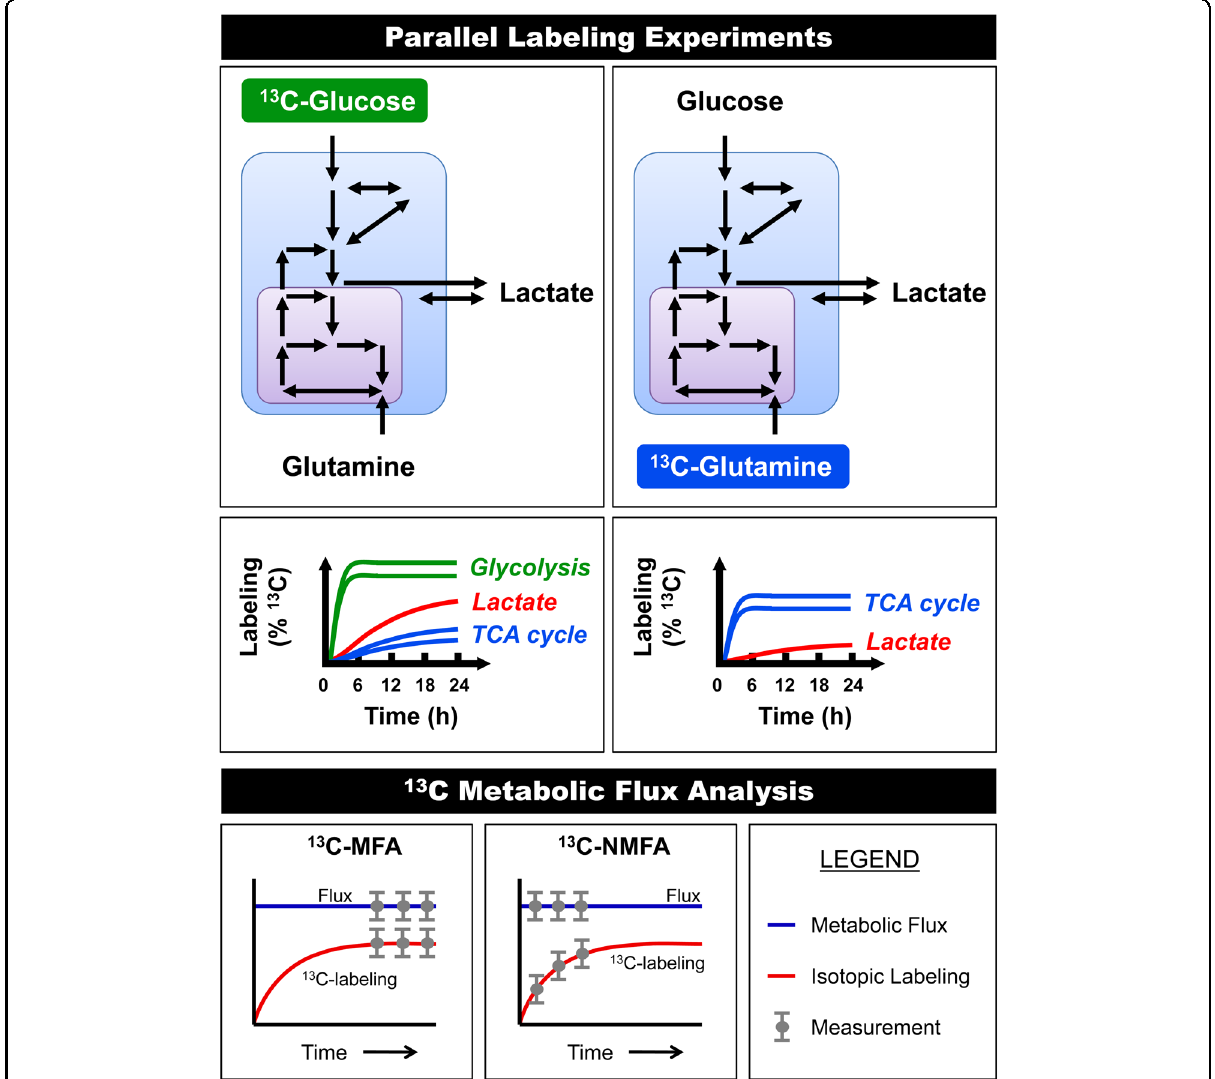
Fig. 3 Parallel labeling experiments with different 13 C-labeled substrates greatly enhance the resolution of metabolic fl uxes in complex models. The rate of labeling incorporation after the introduction of a 13 C-tracer depends on the turnover rate of intracellular metabolites and exchanges between intracellular and extracellular metabolites. In particular, external lactate can slow down labeling of intracellular pyruvate and TCA cycle metabolites from 13 C-glucose tracers. If isotopic steady state is reached then labeling data can be analyzed with 13 C-MFA. However, if the system has not reached isotopic steady state, then the labeling data must be analyzed using isotopic non-stationary 13 C-MFA ( 13